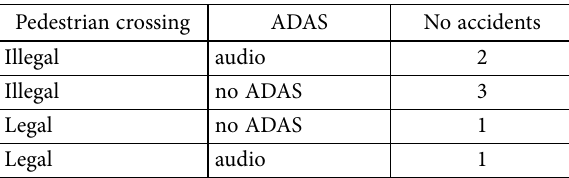
Table 1. Collisions with pedestrian for legal and illegal crossing with or without ADAS Pedestrian crossing ADAS